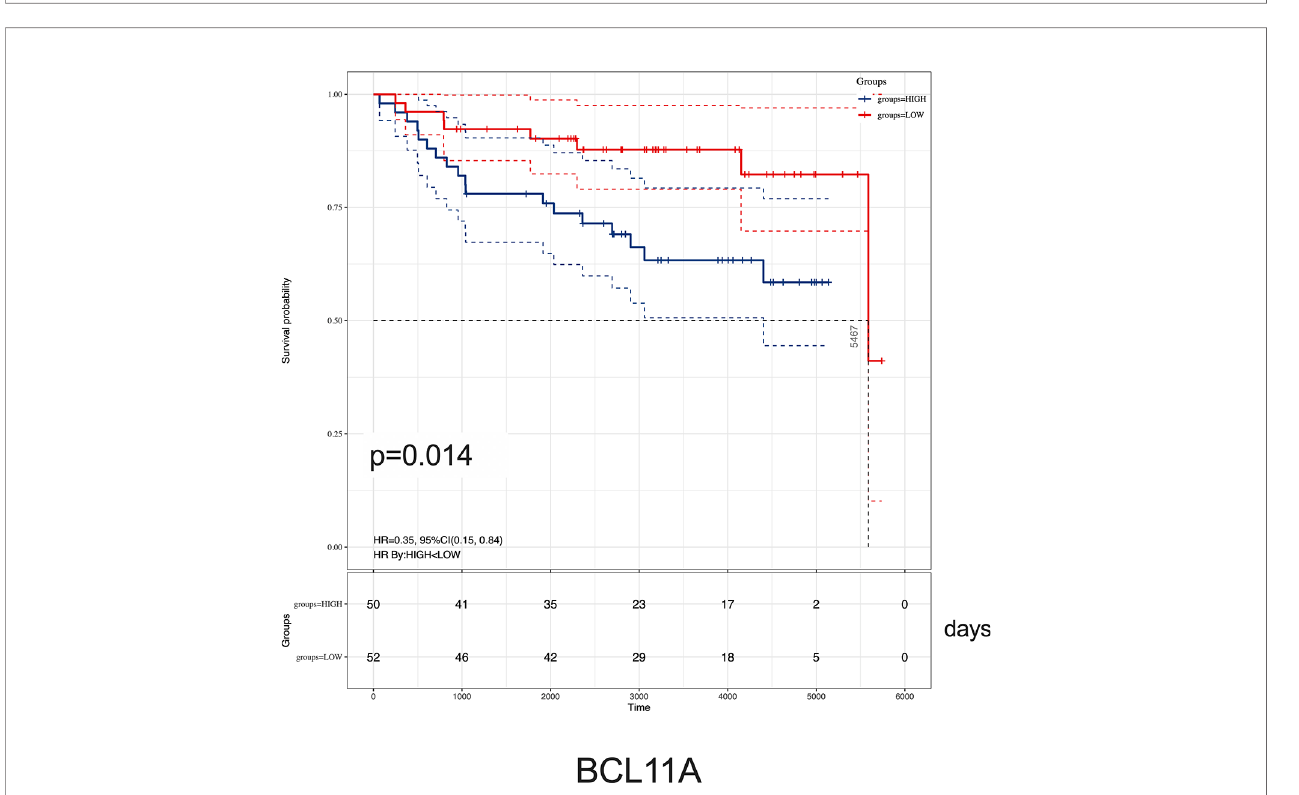
FIGURE 8 | Kaplan – Meier analysis of BCL11A expression in childhood ALL. Survival cure comparing patients with high (blue) vs. low (red) BCL11A expression were plotted using a Log-rank test [HR = 0.35 (0.15 – 0.84), p = 0.014]. The unit of time is measured in days. The median survival time is 5,467 days.